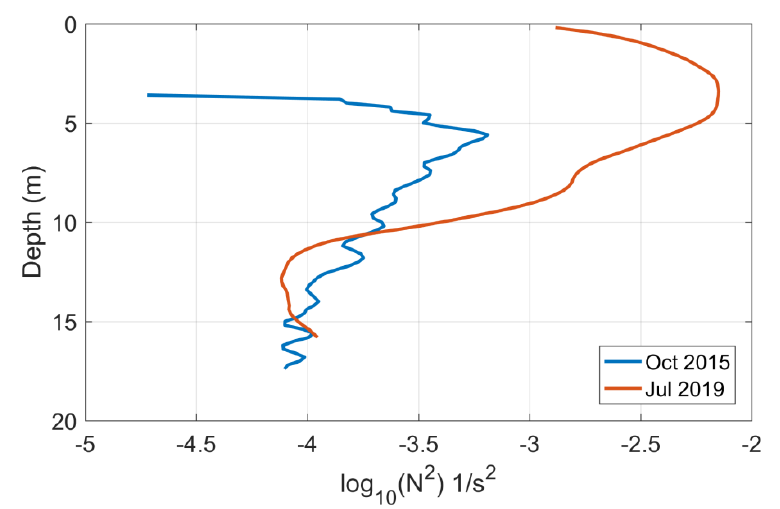
Figure 14. Averaged profiles of buoyancy frequency measured in October 2015 (summer) and July 2019 (autumn).